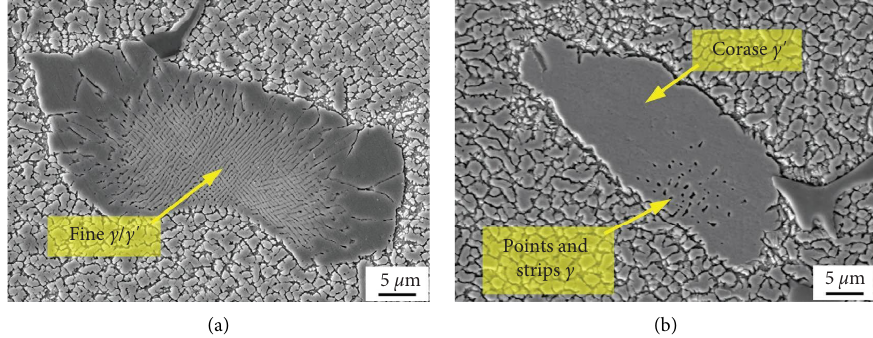
Figure 10: Comparison of the ( c + c ′ ) eutectic structure between as-cast and HIP1185.